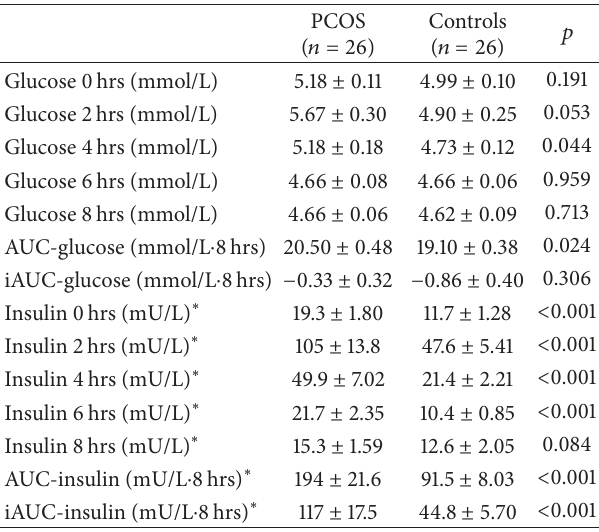
Table 3: Postprandial glucose and insulin.